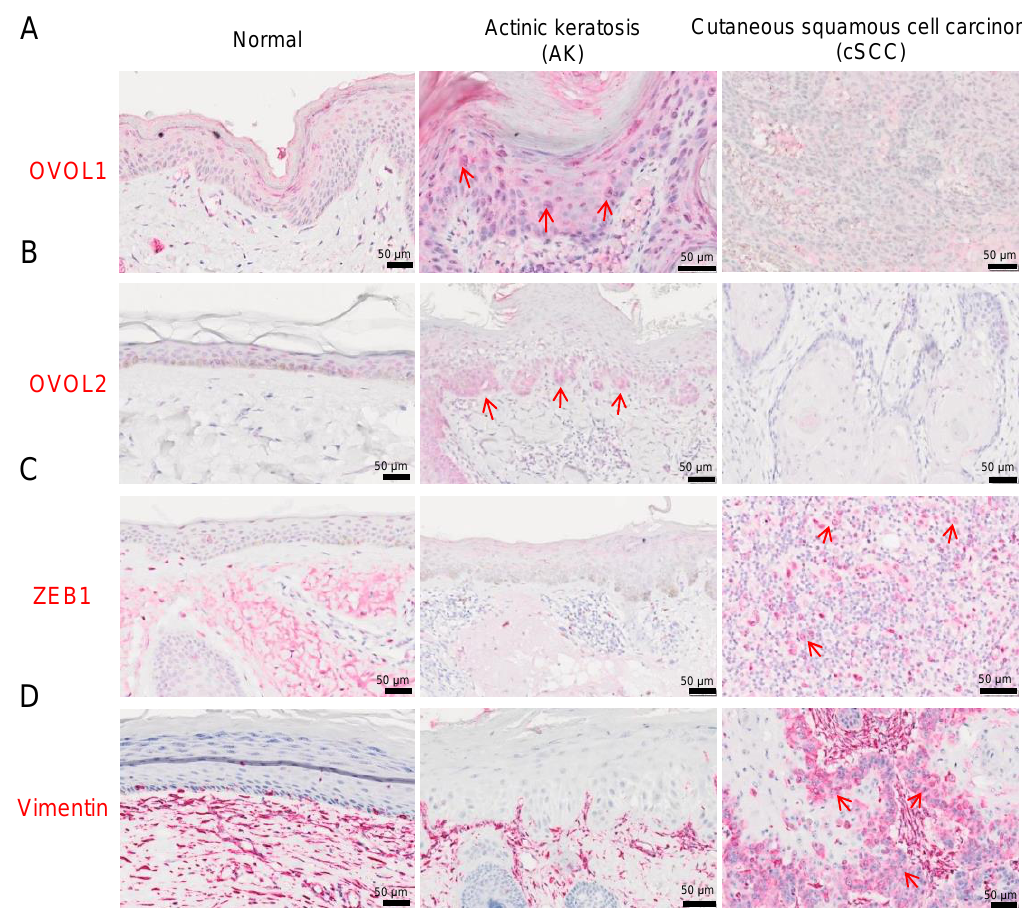
Figure 1. Representative images of OVOL1, OVOL2, ZEB1, and vimentin staining in normal skin (left), AK (middle) and cSCC (right). ( A ) Representative images of OVOL1 staining, ( B ) OVOL2 staining, ( C ) ZEB1 staining, and ( D ) vimentin staining. Red arrows show the positive cells.